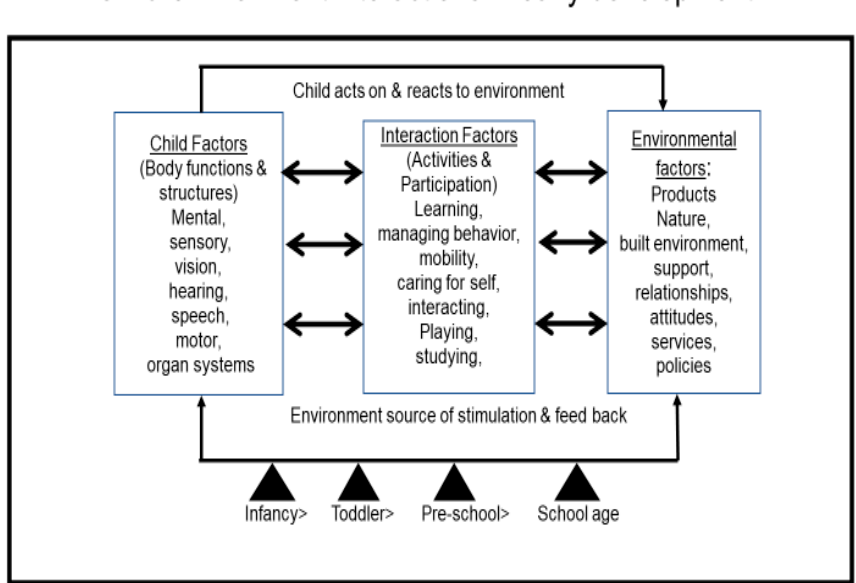
Figure 1. Interactional framework—modeling child ‐ environment interaction within International Classification of Functioning, Disability and Health for Children and Youth (ICF ‐ CY) domains .